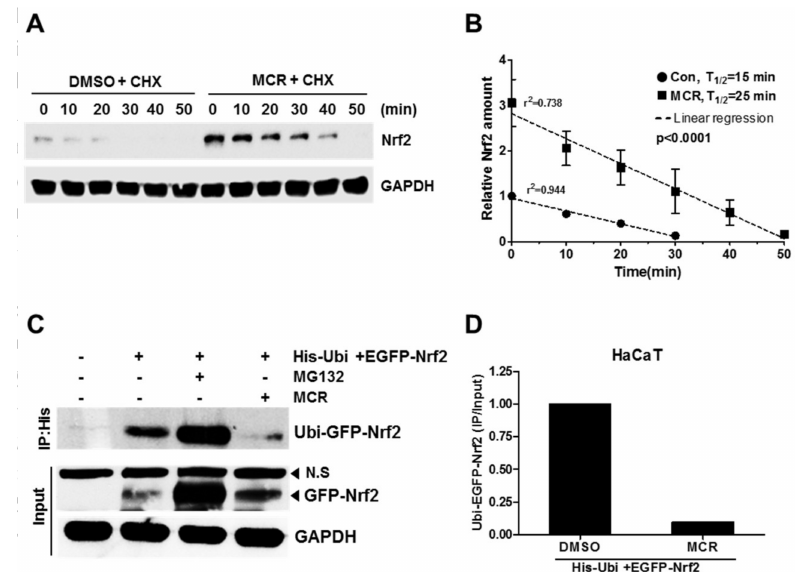
Figure 4. MCR increases Nrf2 stability. ( A ) HaCaT cells were treated with 50 µ M of MCR for 10 h before incubation with 5 µ g/mL CHX for the indicated times, and whole protein extracts were subjected to western blotting; Nrf2 stability was analyzed using densitometer as shown in ( B ); ( C ) Cells were treated with MCR (50 µ M) and/or MG132 (10 µ M) for 12 h after cotransfection with pEGFP-Nrf2 and pcDNA3.1-His ubiquitin. His-ubiquitinated proteins were purified using Ni-NTA agarose beads, and uibiquitinylated GFP-Nrf2 was analyzed using western blotting; The amount of uibiquitinylated GFP-Nrf2 was measured using a densitometer as shown in ( D ). CHX, cycloheximide; Ubi,